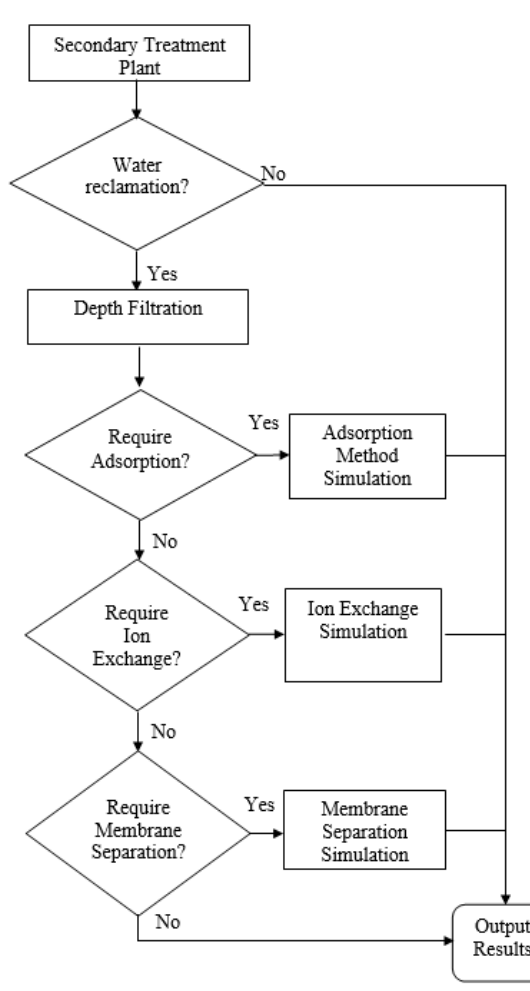
Figure 2. The flow of tool run operation.